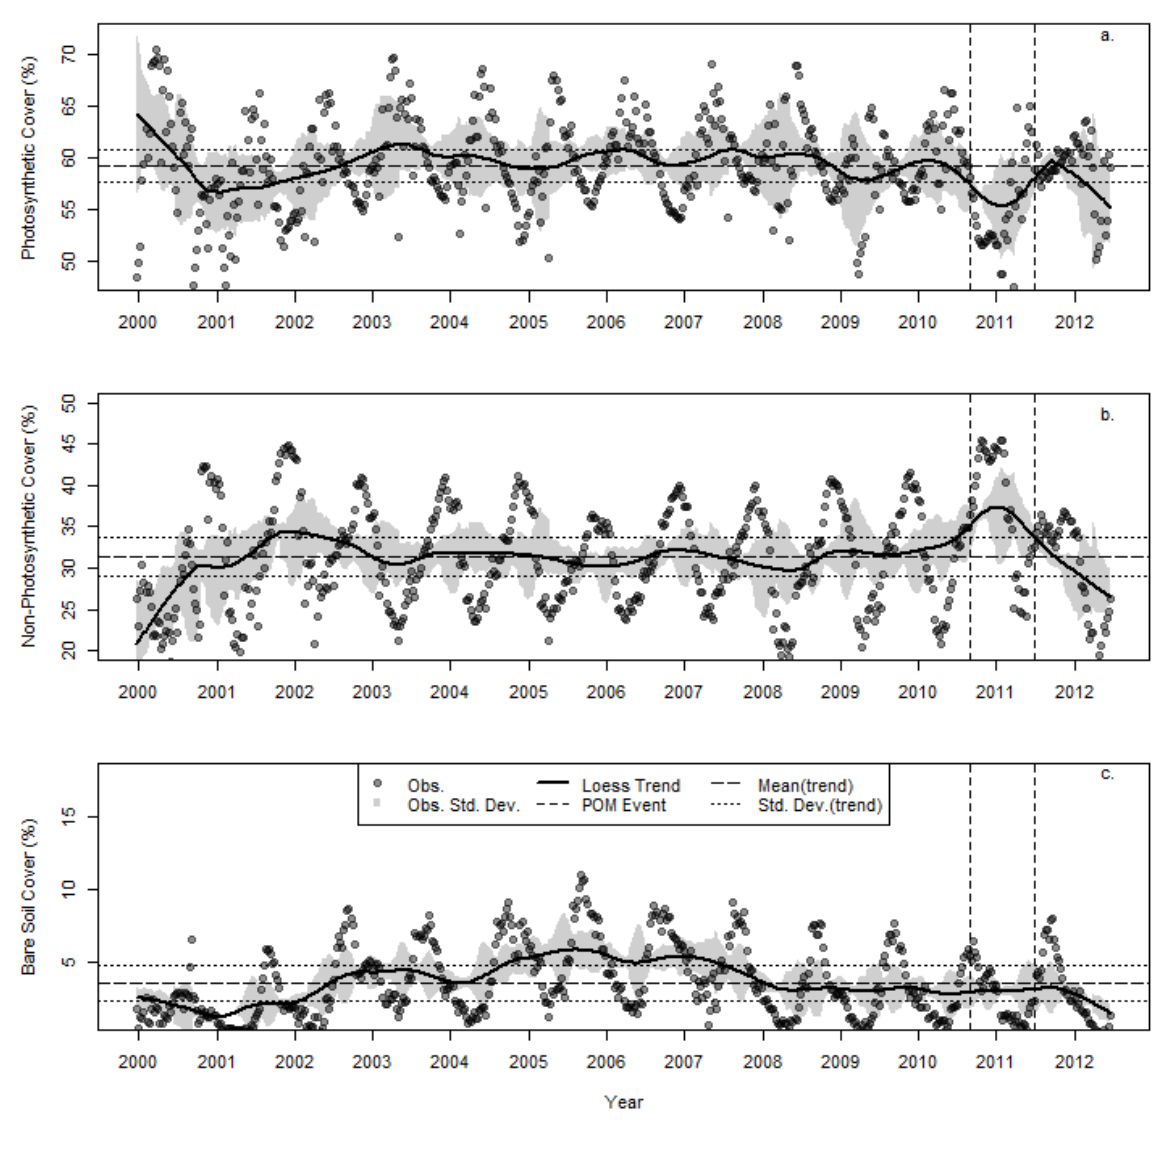
Figure 4. Spatially aggregated 0.5 km study area average Seasonal Trend